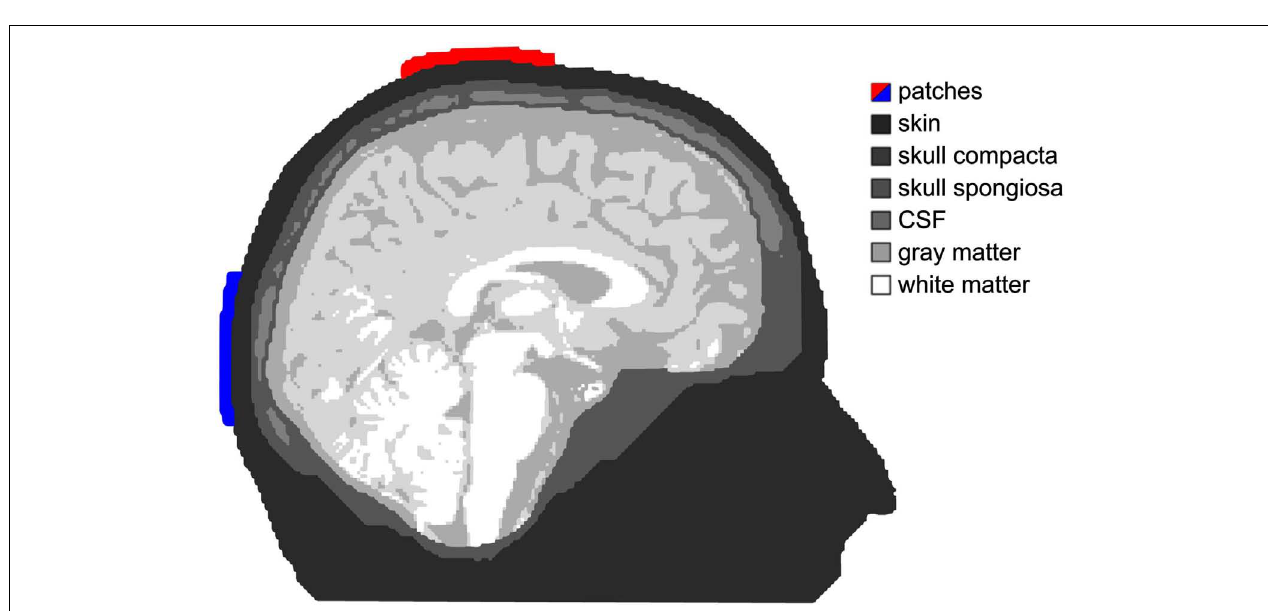
FIGURE 1 |Tissue compartments. Shades of gray depict the different tissue compartments used in our simulation.The anode is colored red and the cathode is blue.This applies for all simulation